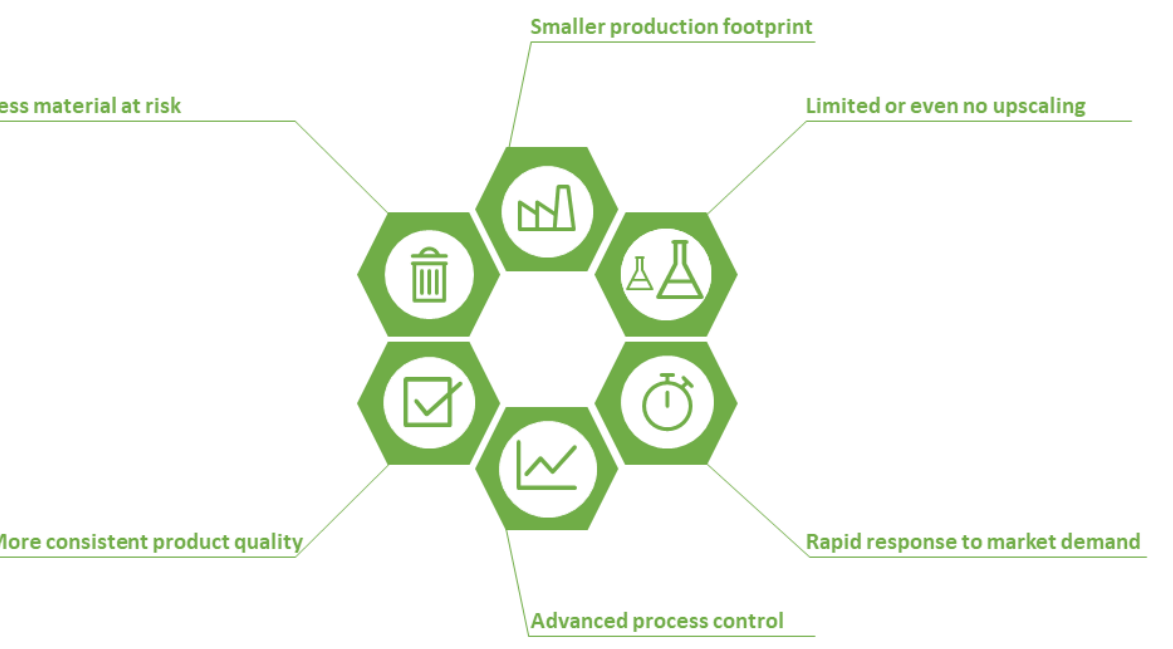
Figure 1. Advantages of continuous manufacturing.